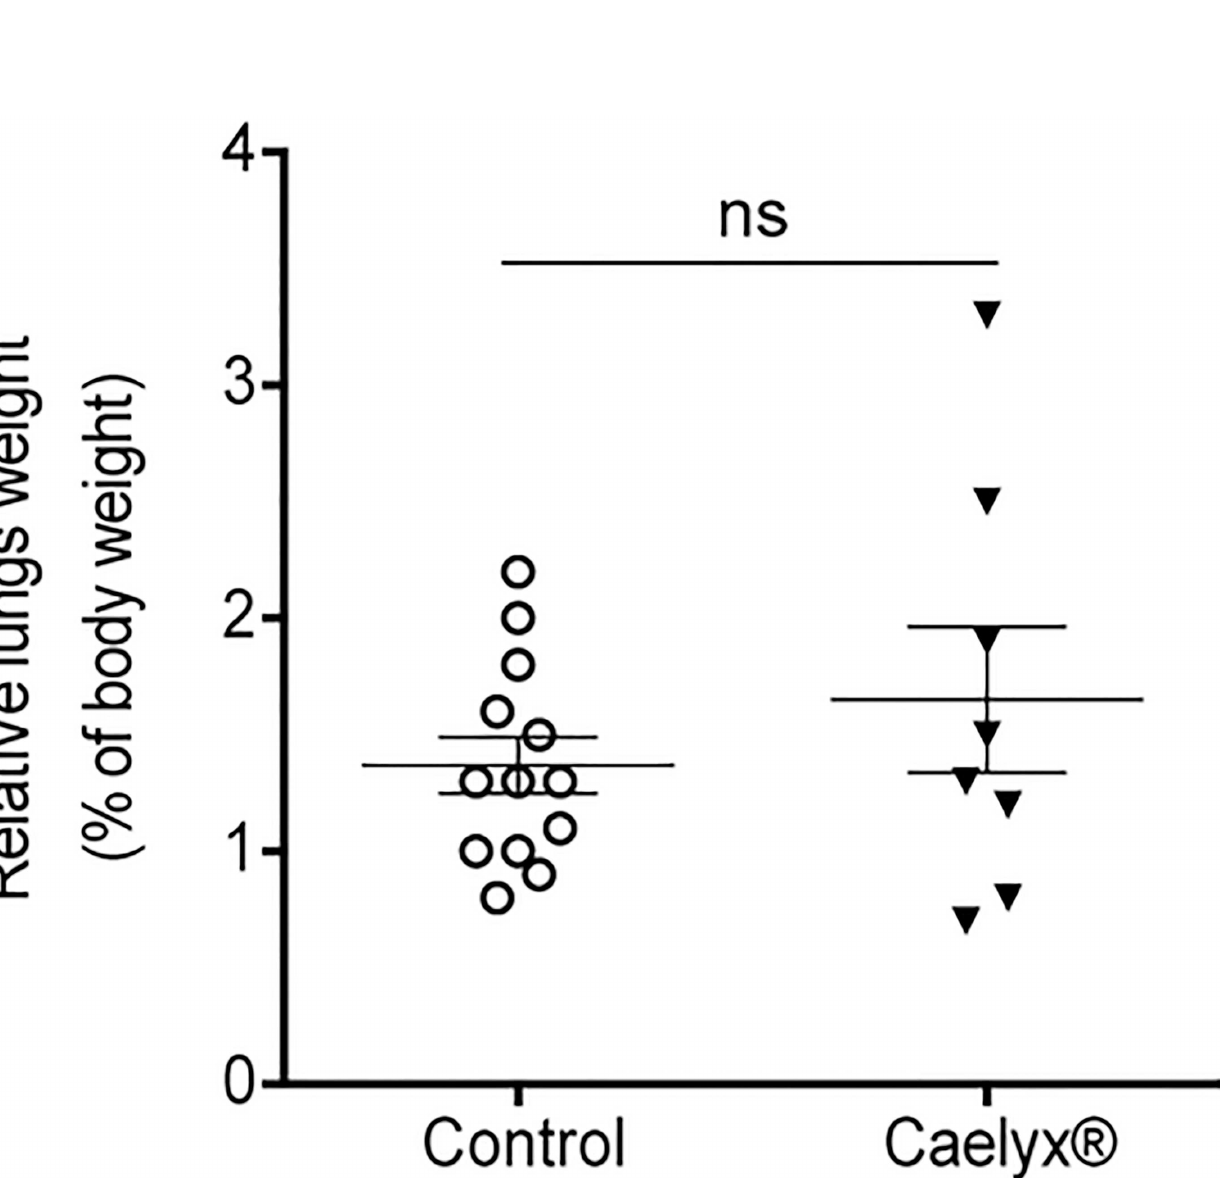
Fig 5. Metastatic burden in the lungs following treatment with Caelyx ® . Metastatic burden was determinedupon organ weight for individual mice treated either with Caelyx ® or saline, and further normalized for the whole body weight. Data represent individual(dots) or mean ± SEM of control (n = 13) and Caelyx ® (n = 6) mice. ns, p > 0.05 two-tailed nonparametric Mann-Whitney